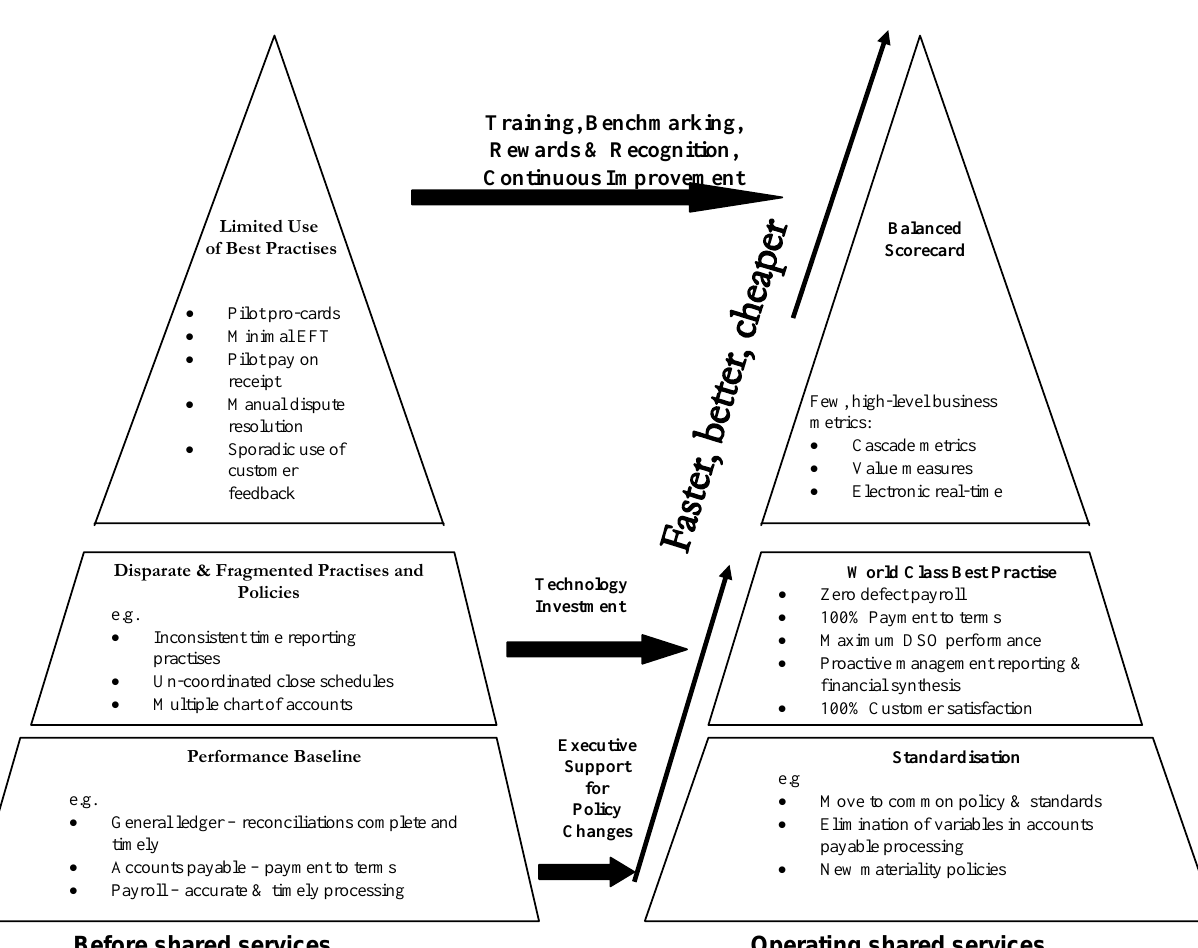
Figure 2: Cascading of